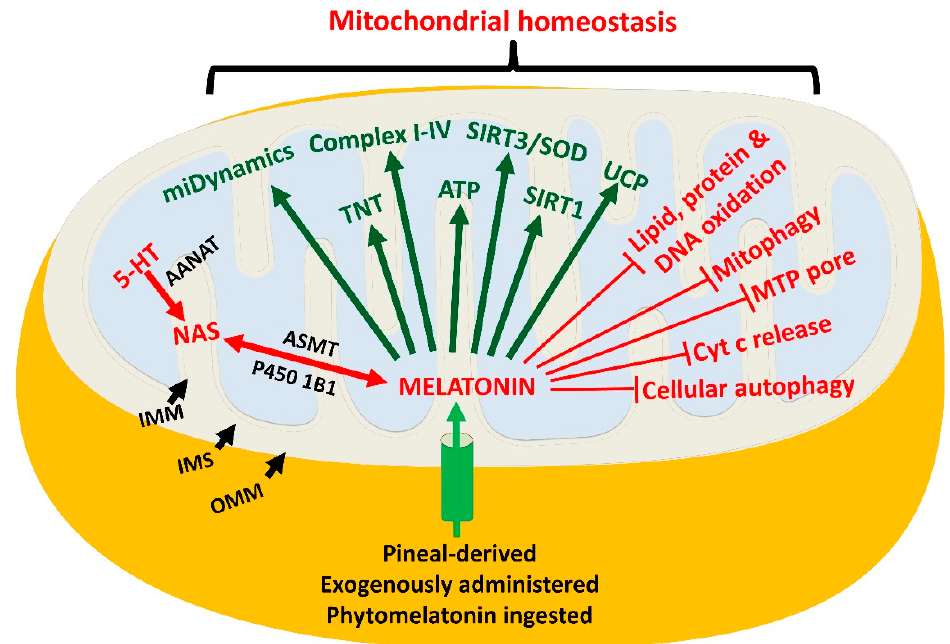
Figure 3. Representative actions of melatonin that involve the mitochondria. Melatonin, derived from the pineal gland, after supplemental ingestion or consumed in the diet is taken up by cells and transported into the mitochondria via the oligopeptide transporters, PEPT1/2. All cells are believed to synthesize melatonin in their mitochondria via the conventional pathway as described in the pineal gland. In mitochondria, melatonin can be reverse-metabolized to its precursor, N-acetylserotonin (NAS); this involves the extrahepatic monooxygenase enzyme, P450 1B1. Thus, the changes induced by melatonin may also involve NAS production. The most recently discovered actions of melatonin that involve the mitochondria are its effects on tunneling nanotubes (TNT) which allow for the transfer of mitochondria between cells. 5-HT = serotonin; AANAT = arylalkyl-N-acetyltransferase; ASMT = acetyl serotonin methyltransferase; Cyt c = cytochrome c; IMM = inner mitochondrial membrane; IMS = Intermembrane space; miDynamics = mitochondrial dynamics; MTP = Mitochondrial permeability transition pore; OMM = outer mitochondrial membrane; UCP = uncoupling protein; SOD = superoxide